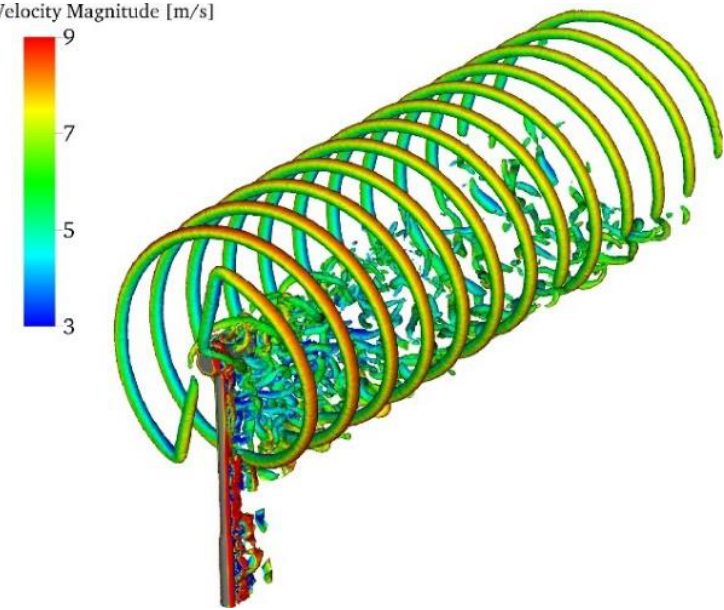
Figure 4. Vorticity isosurfaces ( Q = 15 m 2 /s 2 ) coloured by velocity magnitude for NREL Phase VI wind turbine [36]. Reproduced with permission from Ravensbergen et al., Computers & Fluids; published by Elsevier, 2020.